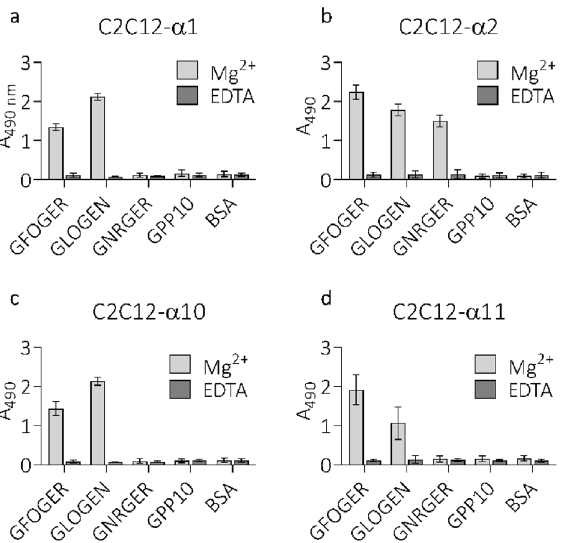
Figure 2. The static adhesion preferences of C2C12 cells that have been stably transfected to express one of the four α1 ( a ), α2 ( b ), α10 ( c ) or α11 ( d ) integrin subunits. Adhesion to collagen-mimetic peptides is shown as A 490 . Light grey bars indicate the presence of 5 mM Mg 2+ to facilitate integrin adhesion. Dark grey bars indicate the presence of 5 mM EDTA to block integrin binding. Data shown are Mean values ± SEM of three repeats performed in triplicate.